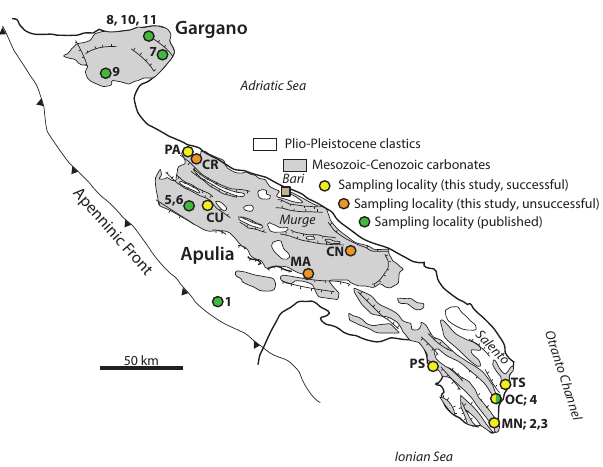
Figure 2. A simplified geological map of the exposed Apulian fore- land (Apulia, southern Italy) indicating our new as well as previ- ously published paleomagnetic sampling sites (modified from Pieri et al., 1997). Numbers and codes correspond to sites listed in Ta- ble